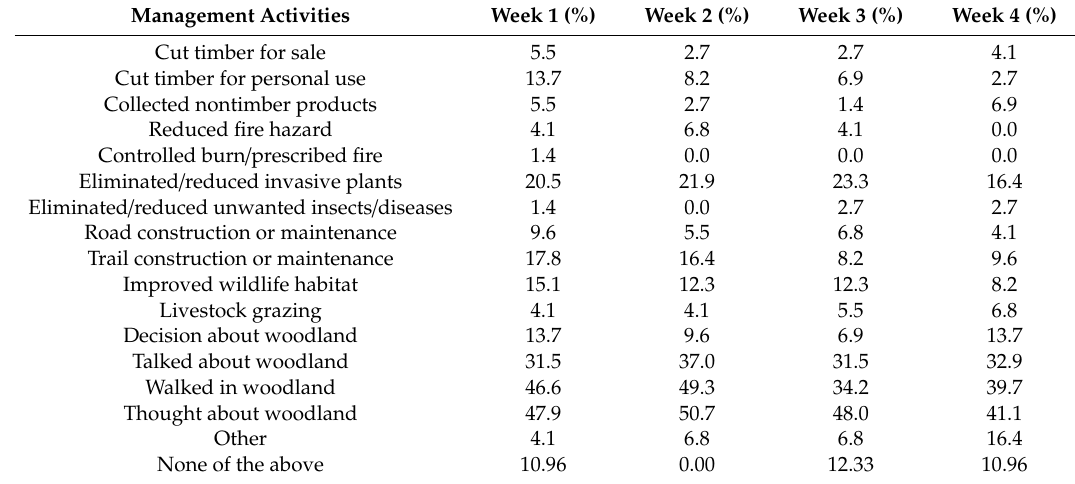
Table 2. Frequency of reported Family Forest Owner Activities by week considering the complete cases (participated all four weeks) and with only the woodland owner association member